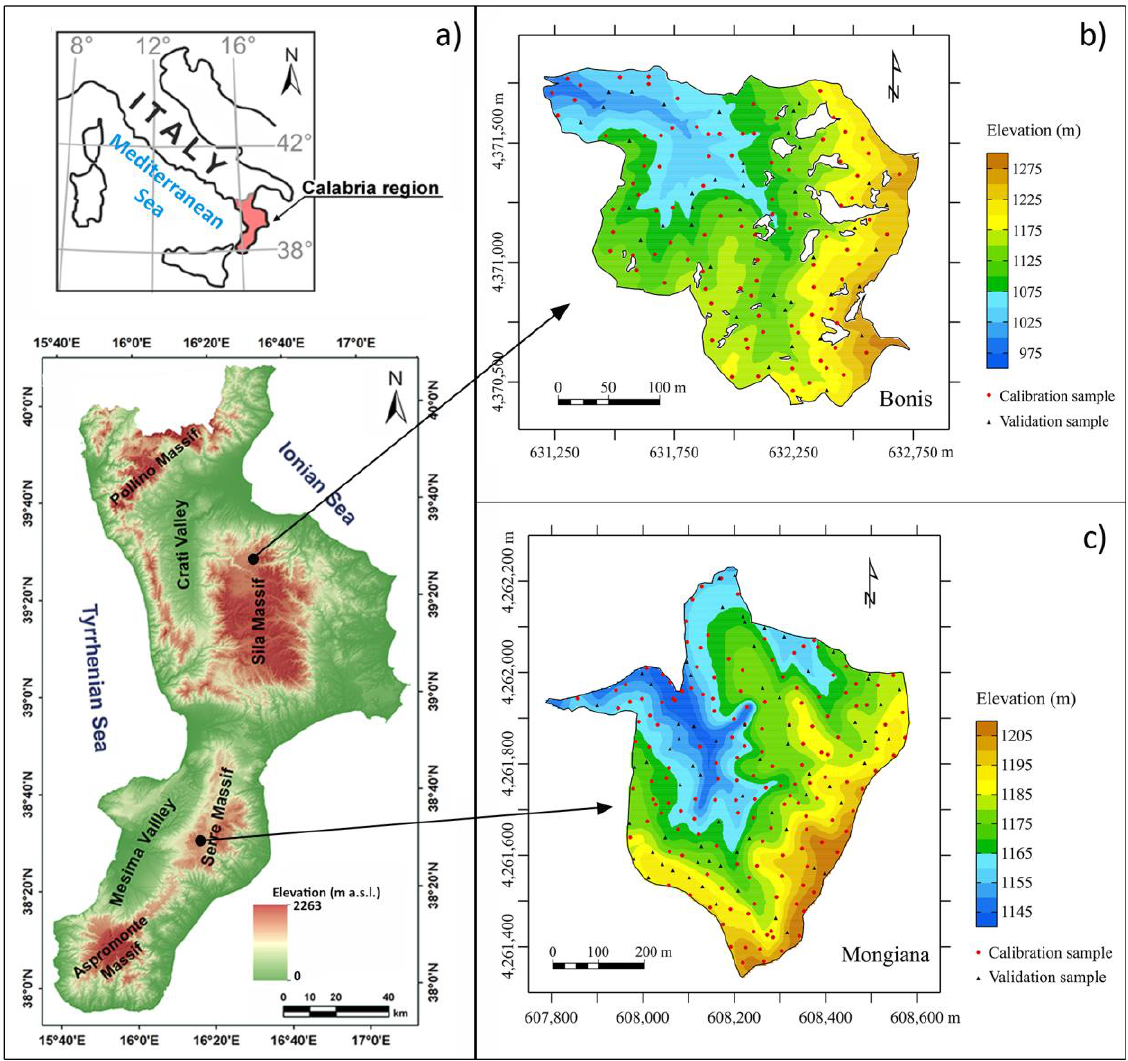
Figure 1. ( a ) Study area locations; ( b ) Bonis catchment; ( c ) Mongiana site. Soil sample locations used for calibration (red dots) and validation (black dots) are also reported.